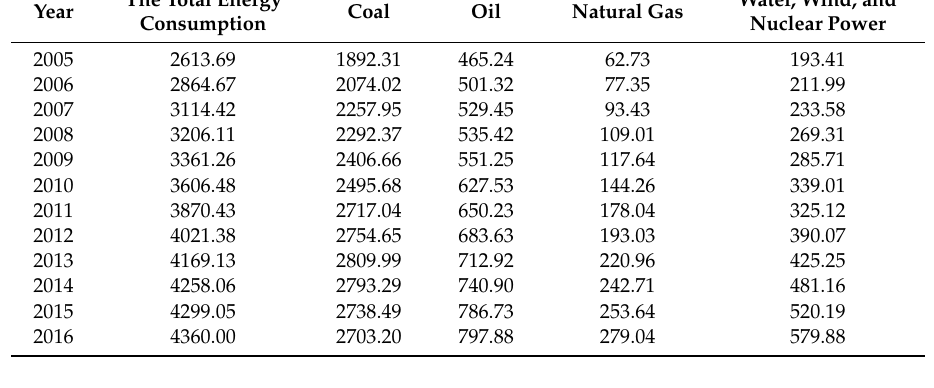
Table 12. The energy consumption of China from 2005–2016 (units: million ton coal equivalent (mtce)).